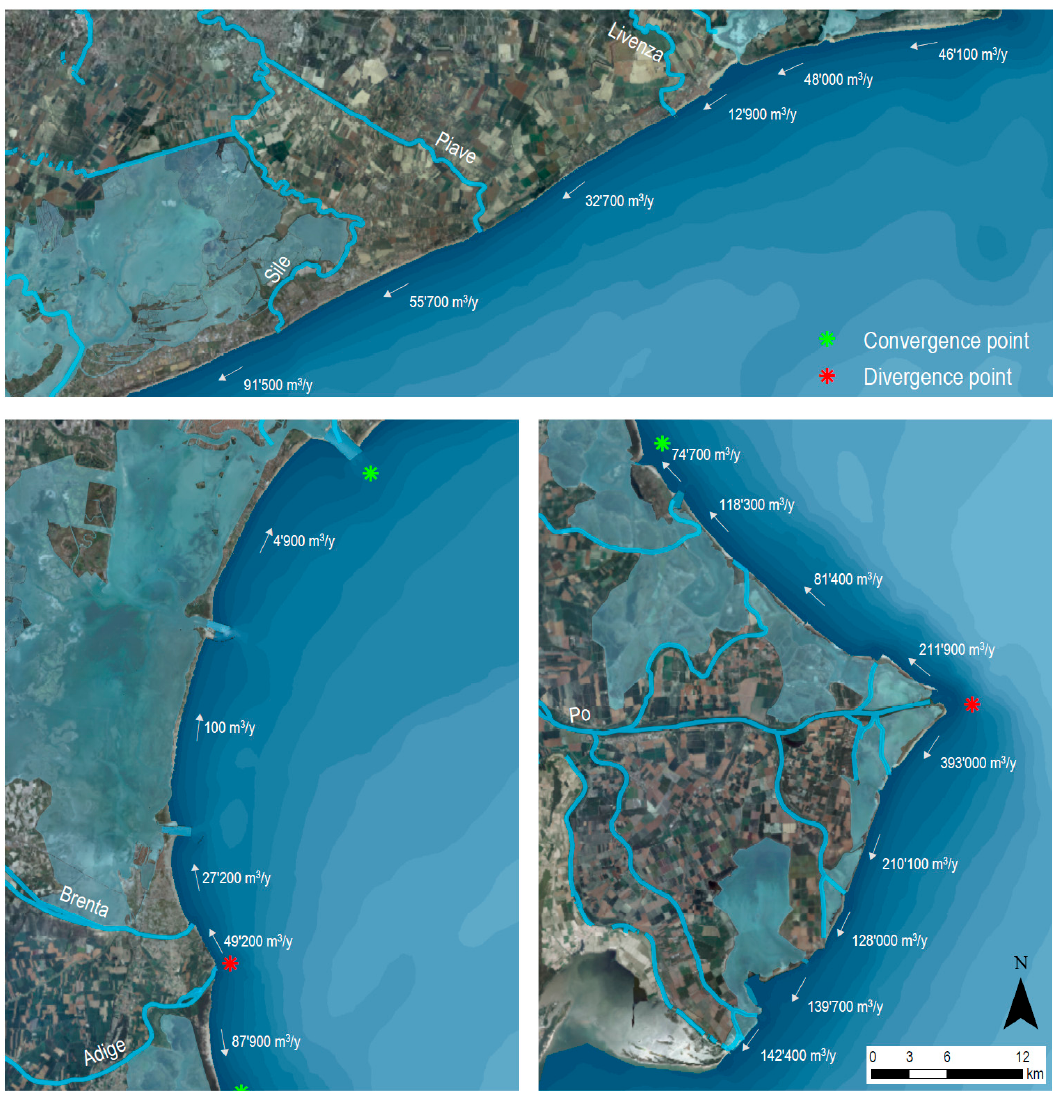
Figure 9. Long-shore sediment transport for the Venetian littoral.